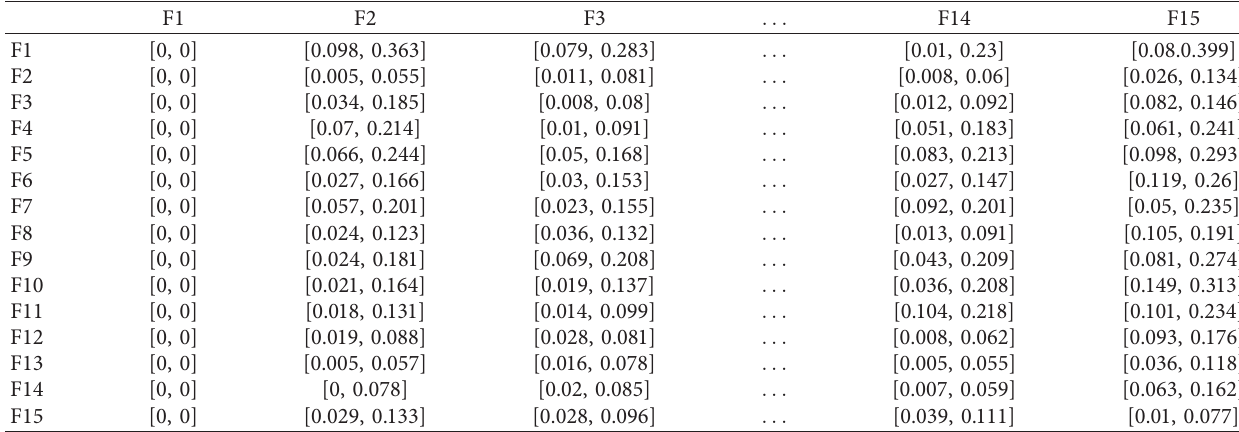
Table 4: The rough total-relation matrix of land-lost farmers’